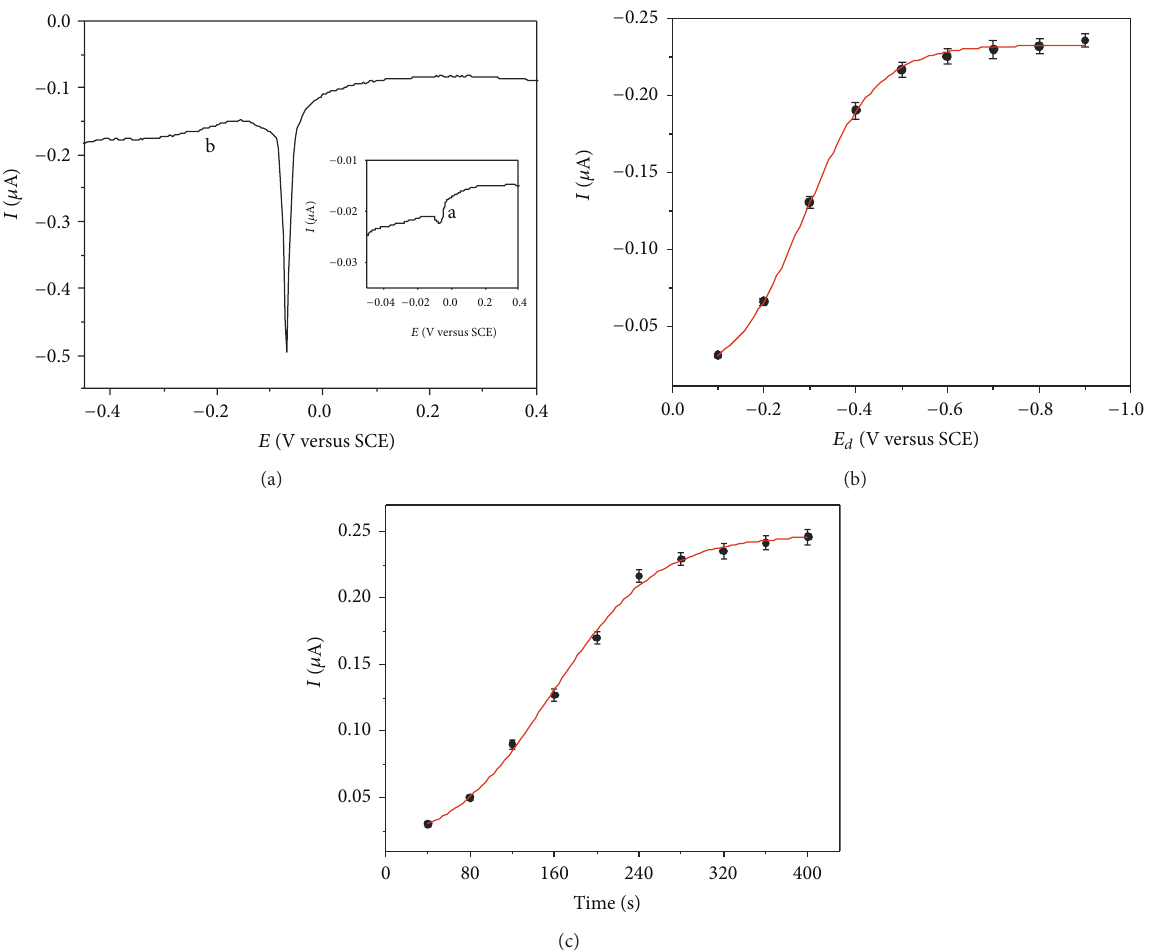
Figure 3: Effects of (a) working electrode, (a) GCE and (b) PAA/PDCNT-GCE, (b) deposition potential ( 𝐸 𝑑 ), (c) deposition time, on the DPV current of released Ag + from 500 cfu/mL E. coli O157:H7 system.